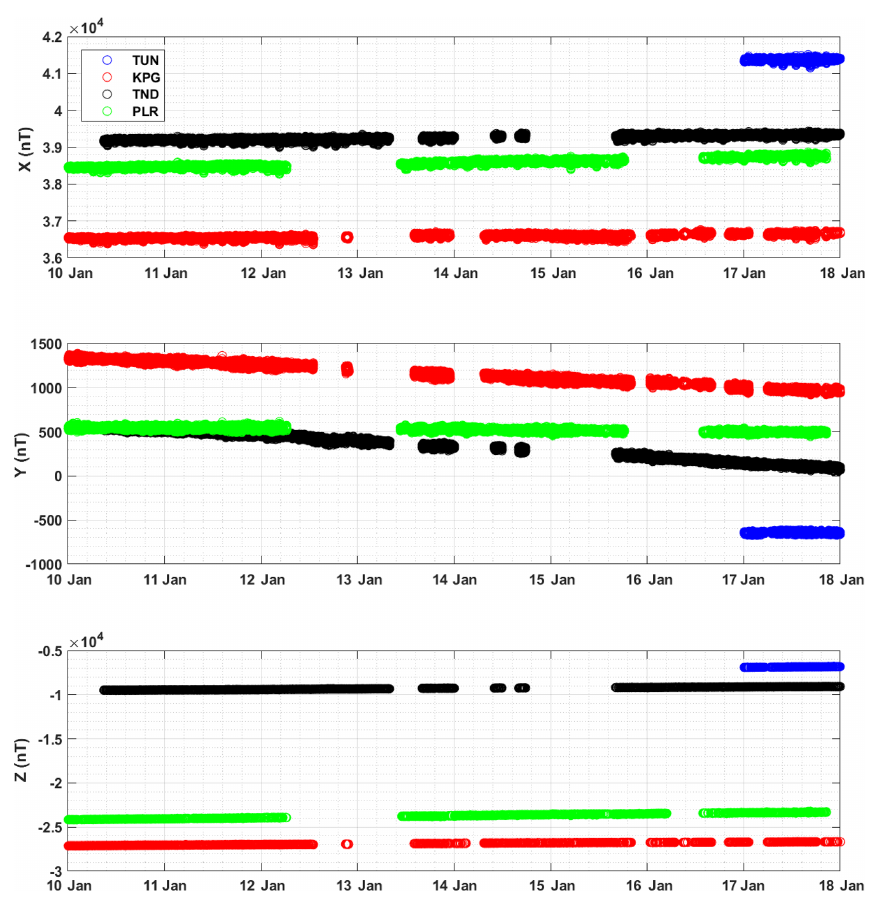
Figure 4. Hourly means at Indonesian observatories in the WDC-G data portal for the period 2010–2017.